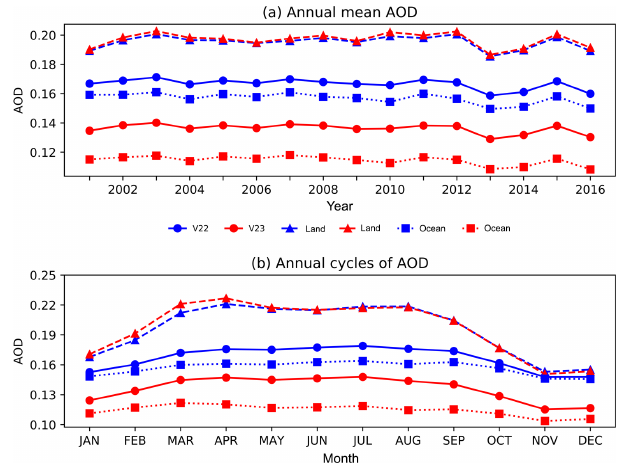
Figure 3. (a) Time series of area-weighted annual mean AODs from V22 (blue) and V23 (red) between 2001 and 2016. Sold lines with circles, triangles with dashed lines, and squares with dotted lines represent global mean AOD, AOD averaged over land, and AOD averaged over ocean, respectively. (b) Annual cycles of AOD. AOD for each month is averaged for the 16